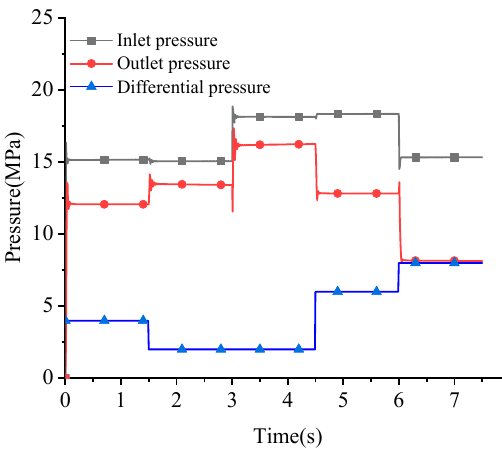
Figure 15. Pressure difference control simulation curve.